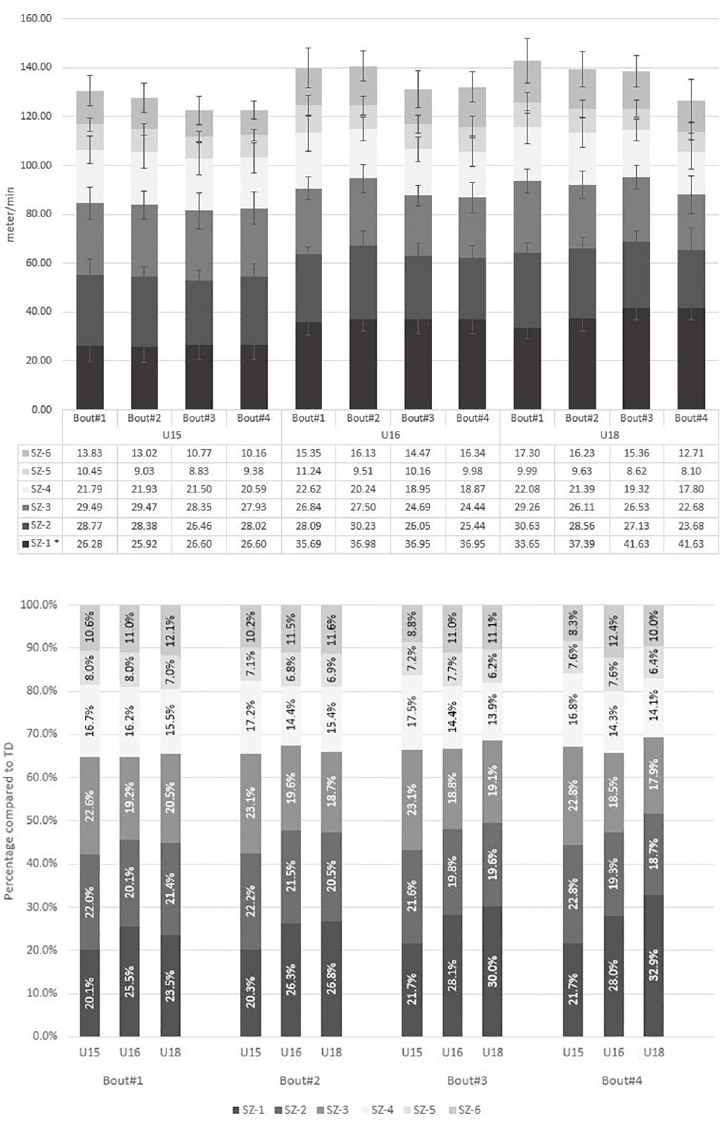
Fig 1. Distance covered in different speed-zones over the course of training concerning age groups. Panel A presents distance covered in different speed-zones as mean-values in m/min. Panel B shows % of distance covered in different speed-zones compared to total distance covered. SZ 1: 0–6.9 km � h -1 , SZ 2: 7–9.9 km � h -1 , SZ 3: 10–12.9 km � h -1 , SZ 4: 13–15.9 km � h -1 , SZ 5: 16–17.9 km � h -1 and SZ 6: � 18 km � h -1 . Dark grey colored bars stand for low-intensity- running ( < 13 km � h -1 , SZ 1–3) and light grey colored bars for high-intensity-running ( � 13 km � h -1 , SZ 4–6) values. � Significant differences (P � 0.05).